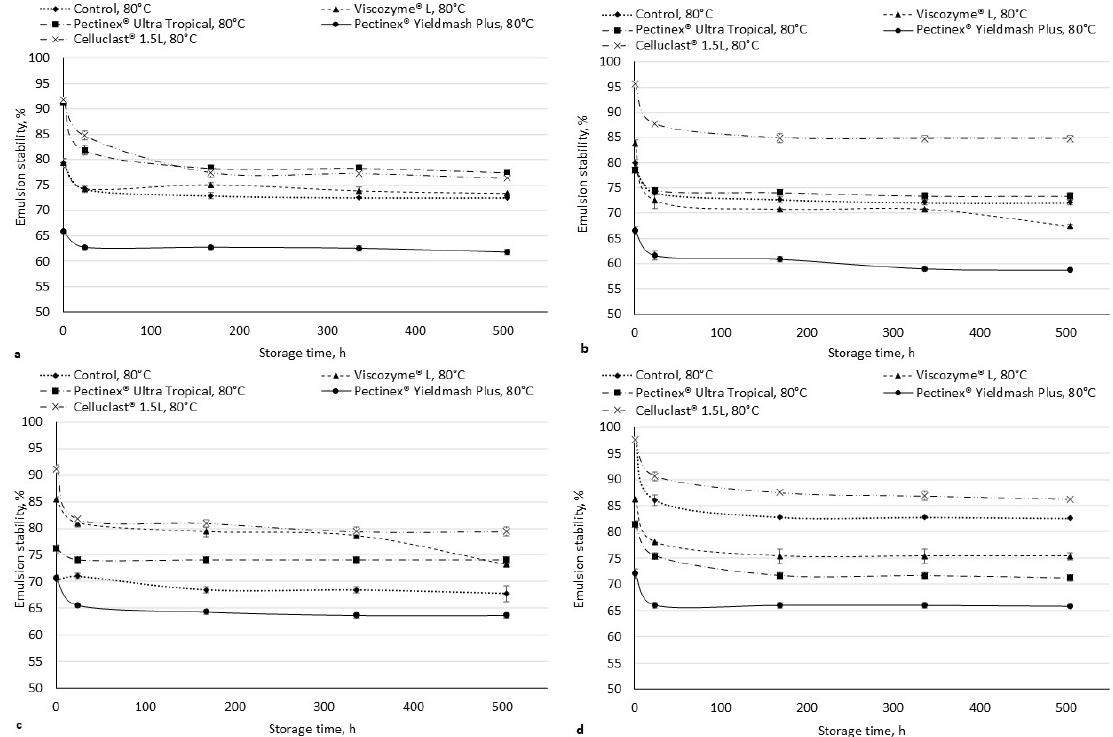
Figure 2. Thermal emulsion stability of enzymatically hydrolyzed cranberry pomaces at pH 3.27 (water) ( a ); 4 ( b ); 6 ( c ); 8 ( d ). Data values are expressed as means with the standard deviation ( n = 3).